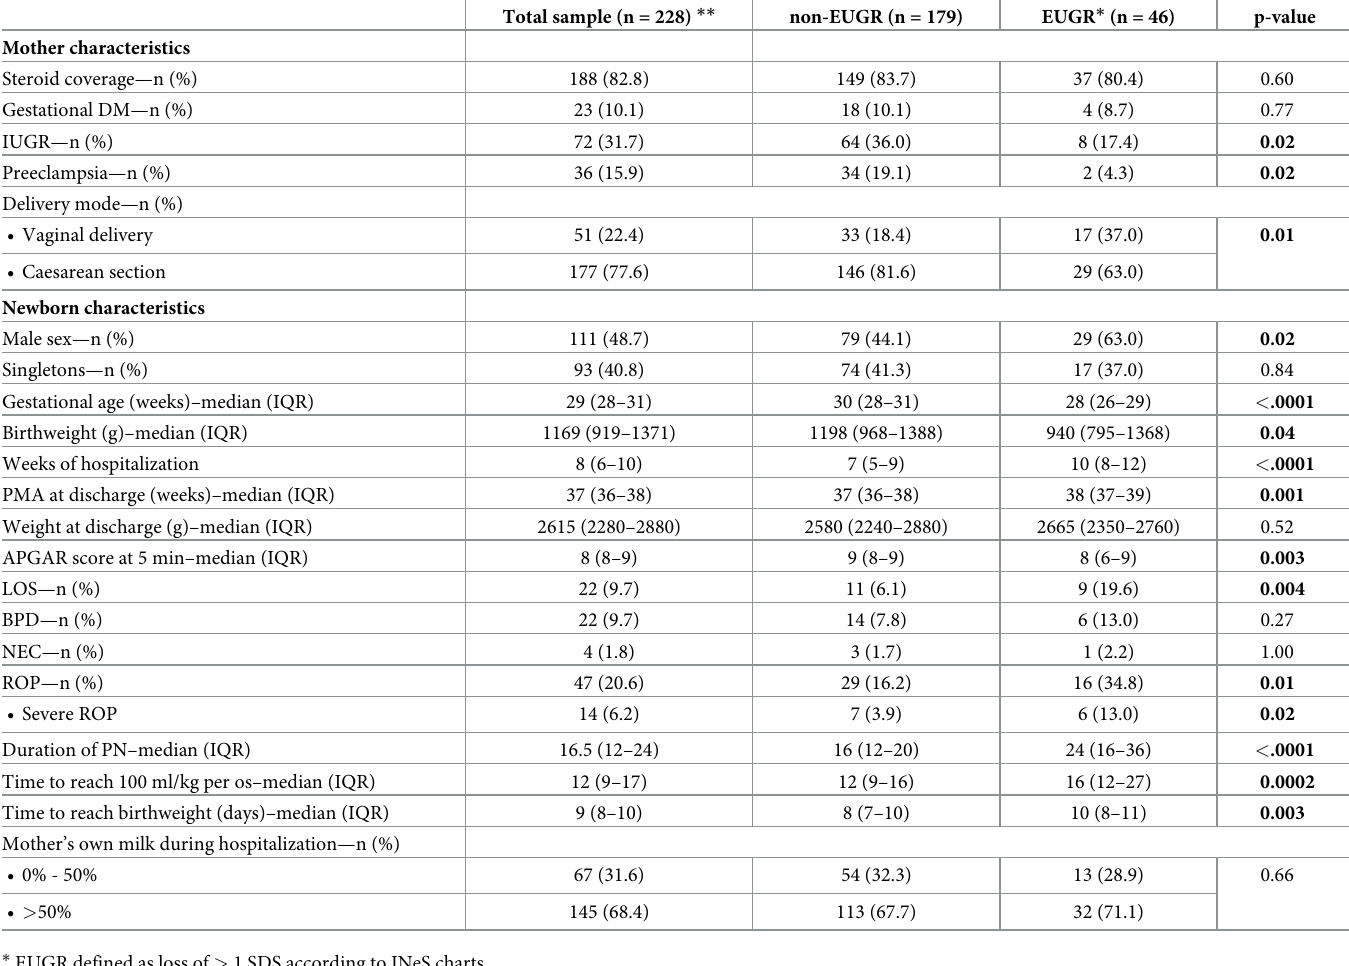
Table 2. Study population characteristics according to EUGR status (defined as loss of > 1 SDS and according to INeS charts).